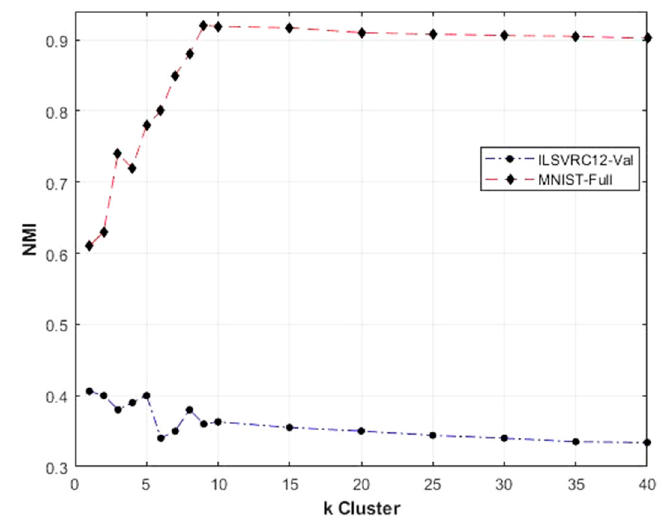
Figure 4. Comparison of NMI performance of the proposed method versus the number of k clusters.